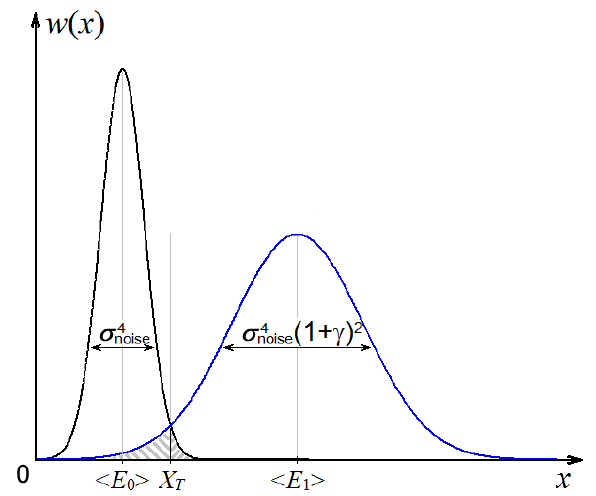
Figure 2. Energy distribution functions for symbols “0” and